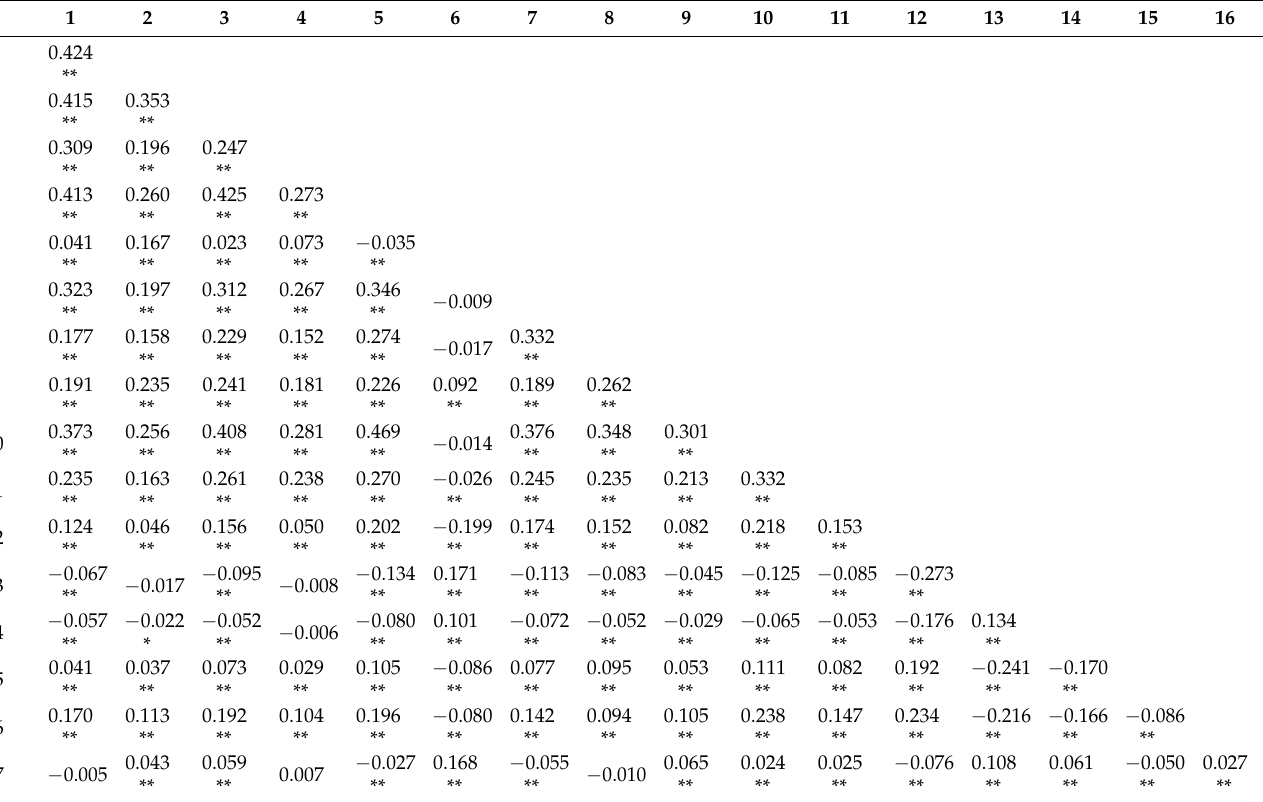
Table 2. Correlation matrix (17 indicator variables) 1